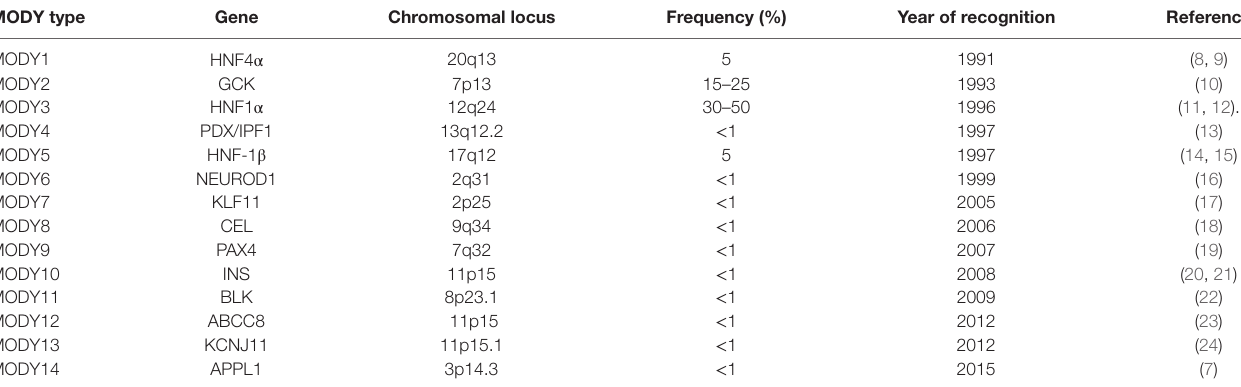
TAbLe 1 | Genes associated with various maturity-onset diabetes of the young (MODY) types including frequencies and year of recognition of various MODY